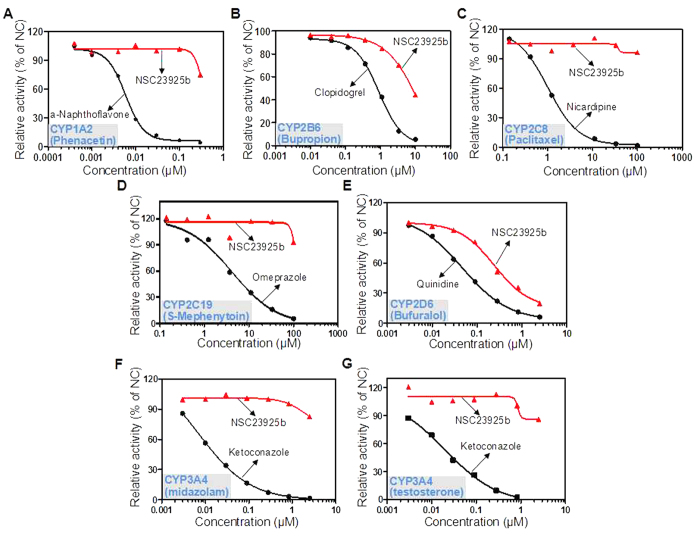
Comparison of inhibitive potentials between NSC23925b and reference inhibitors on human cytochrome (CYP) 450s (CYP1A2, 2B6, 2C8, 2C19, 2D6, and 3A4).The concentration-effect sigmoid-shaped plots of NSC23925b and particular reference inhibitor against the respective CYP450 enzyme, CYP1A2 (A), CYP2B6 (B), CYP2C8 (C), CYP2C19 (D), CYP2D6 (E), and CYP3A4 (F,G). The red triangles and line represent NSC23925b, and the black dots and line indicates the reference inhibitors. “NC” stands for normal control (saline).